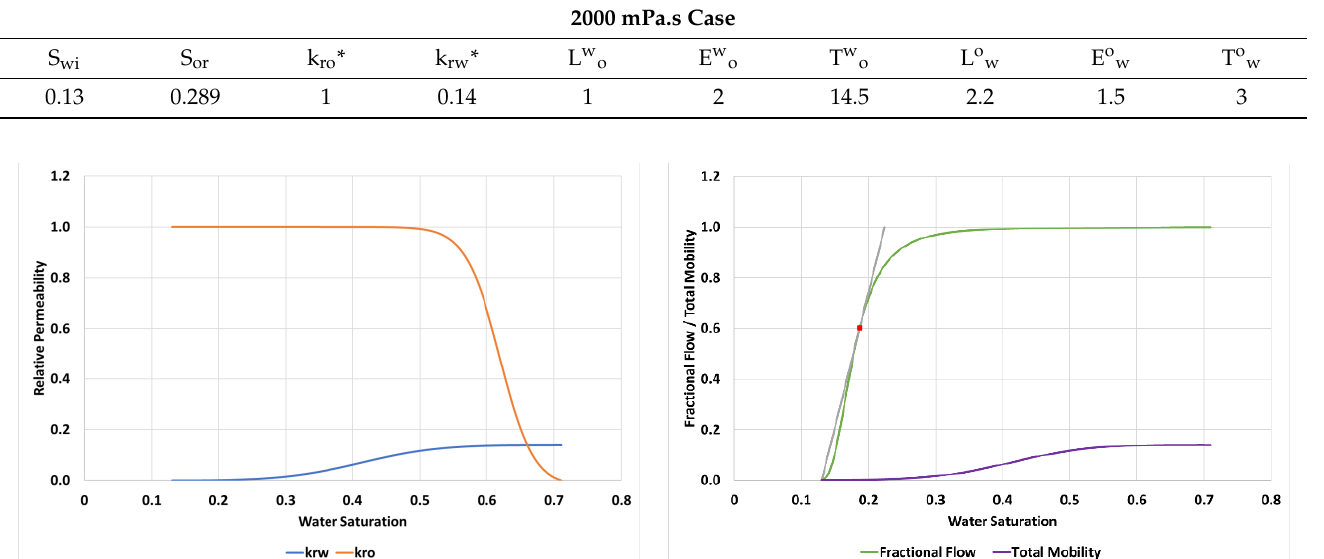
Figure 6. Relative permeabilities ( left ) and fractional flow & total mobility ( right ) for the displacement of 2000 mPa.s oil.